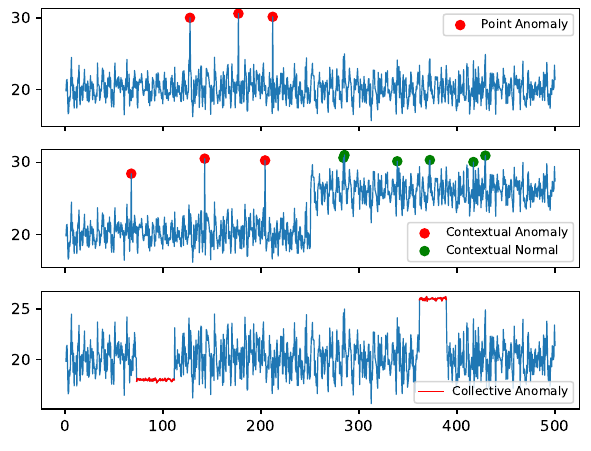
Figure 1. Types of